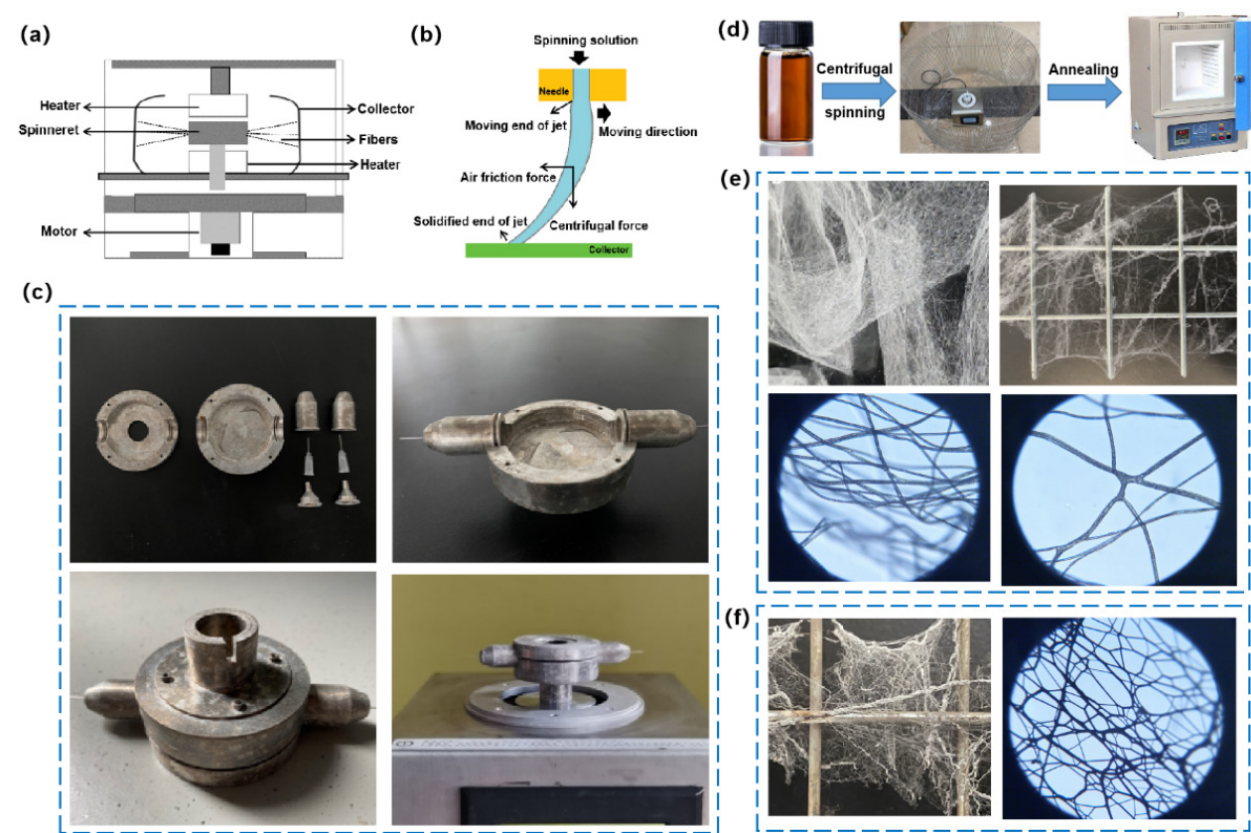
Figure 1. Centrifugal spinning principles, device, and procedure for preparing ultra-long silver microfibers. ( a ) A schematic diagram of the centrifugal spinning equipment. ( b ) Force diagram of a spinning fluid. ( c ) Homemade centrifugal spinning apparatus based on a spinning coater. ( d ) Schematic representation of silver microfibers produced by centrifugal spinning and post-annealing. ( e ) Photographs of centrifugal-spun silver precursor fibers. ( f ) Photographs of centrifugal-spun silver precursor fibers after annealing.